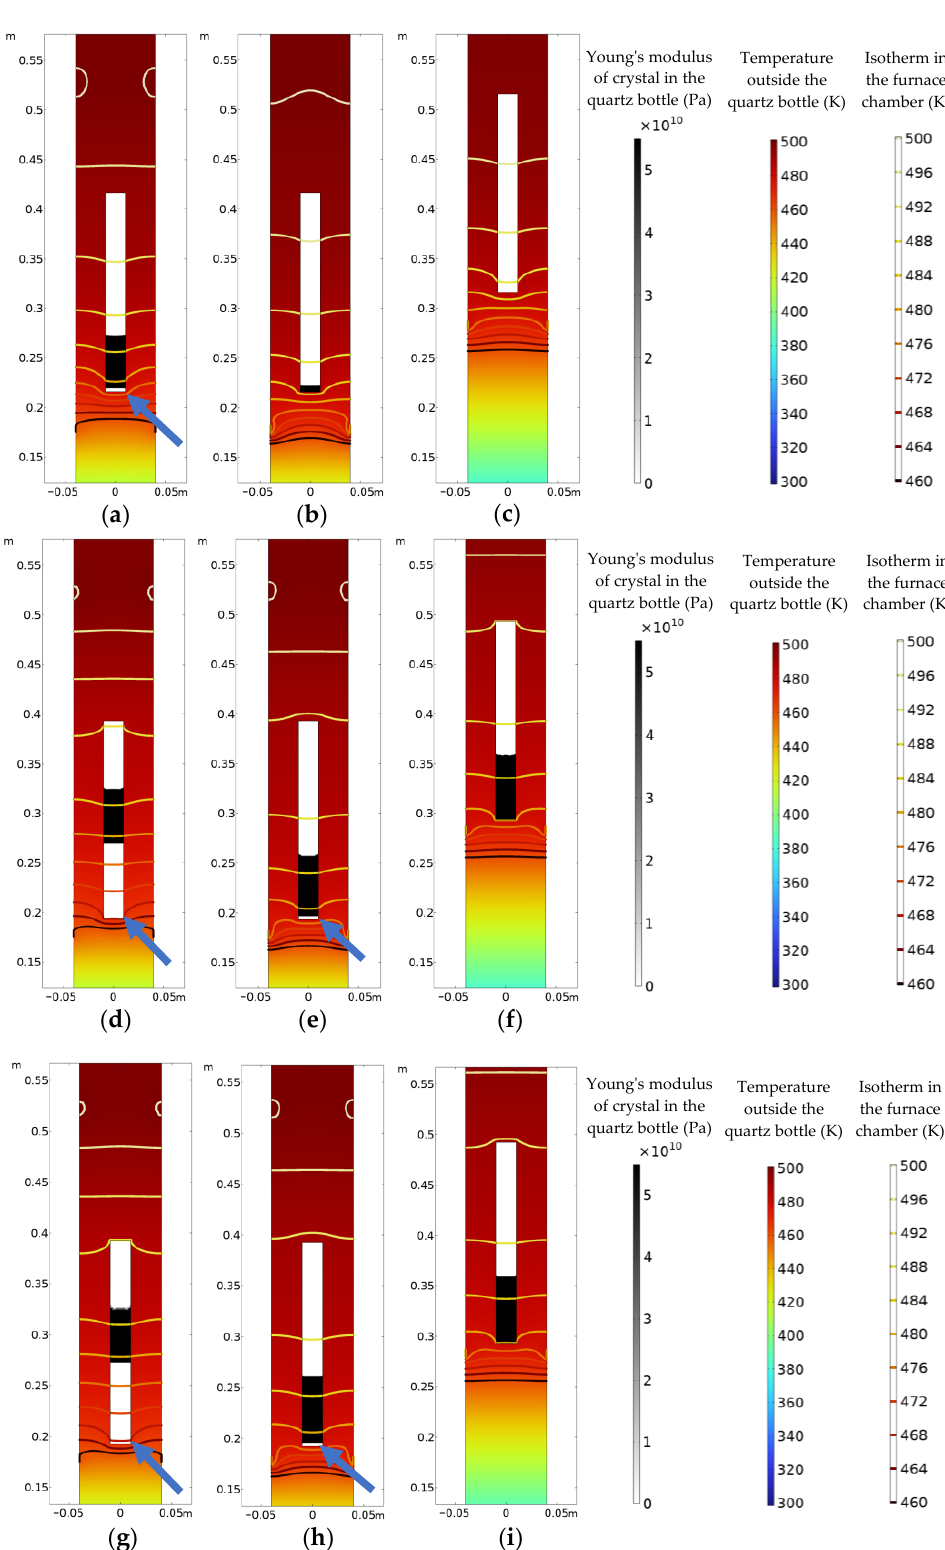
Figure 5. Crystal growth along the c -axis: ( a – c ) 130,000 s; ( d – f ) 210,000 s; ( g – i ) 215,000 s; ( a , d , g ) for process A; ( b , e , f ) for process B; ( c , f , i ) for process C.